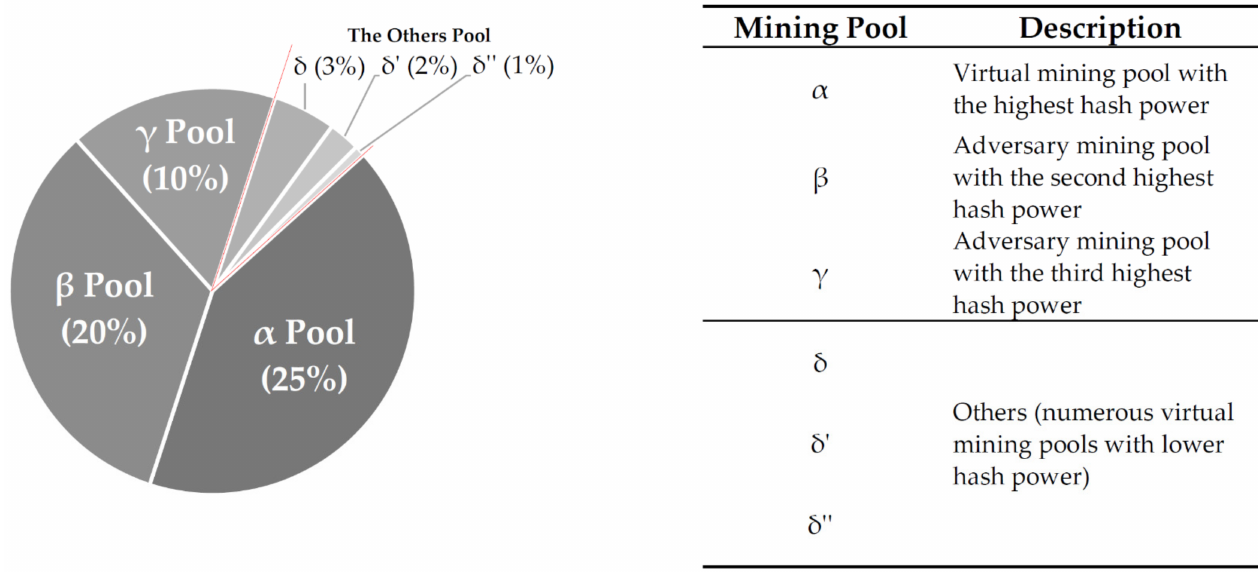
Figure 9. Hash Power Distribution in the